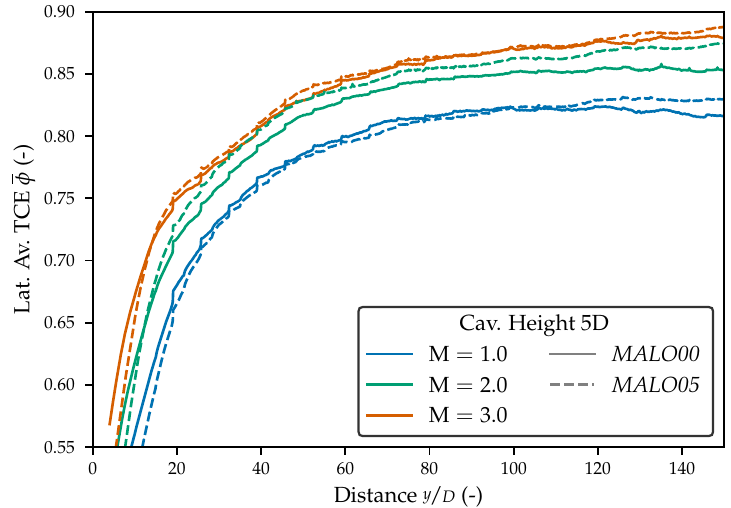
Figure 5. Laterally averaged total cooling effectiveness on hot gas side; nominal cavity height 5 D .